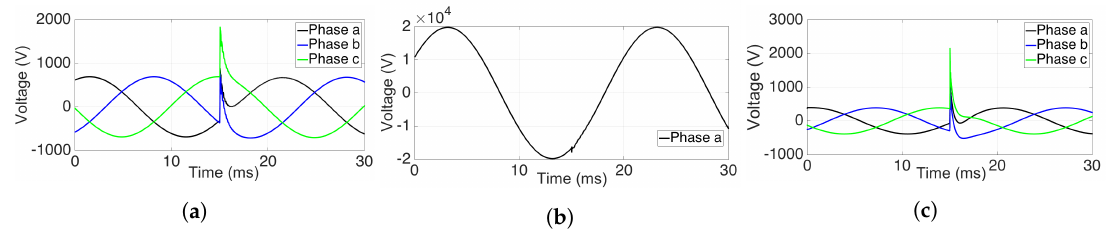
Figure 13. Impact of direct strike on in-service wind turbine overvoltages. ( a ) LV side of the main transformer; ( b ) HV side of the main transformer from node to ground; ( c ) control circuits.